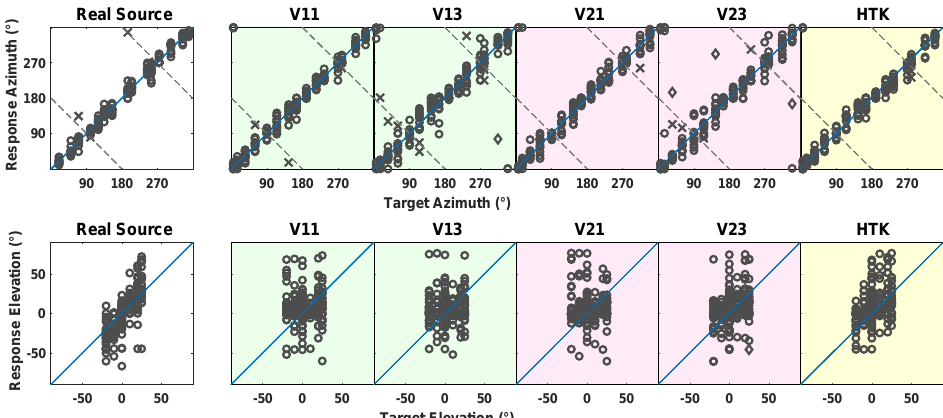
Figure 5. ( Top ) Response azimuth (ordinate) vs. target azimuth (abscissa) and ( Bottom ) response ele- vation (ordinate) vs. target elevation (abscissa), when listening to real sources in TestReal (Real Source) or to virtual sources in TestVR (generated with V11, V13, V21, V23 and HTK). The circles represent the responses of the 14 subjects. Responses marked with ♦ indicate invalid localizations. Responses classified as front–back reversals are marked with × in the top row. Dashed lines represent possible subject responses in cases of perfect front–back